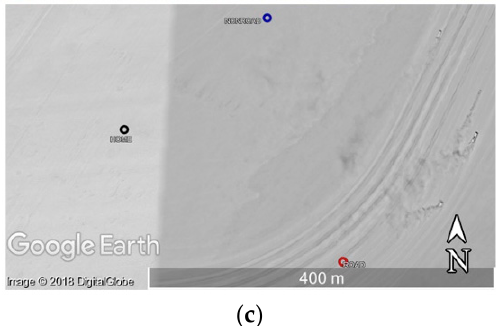
Figure 9. Field site locations: ( a ) Overview of Black Rock Desert (BRD) located north of Reno. ( b ) Zoomed-in Google Earth image over the BRD showing proximity to annual Burning Man Festival (the half circle). ( c ) Zoomed in Google Earth image over the location where measurements were made. The blue circle (most north) represents “non-road” (40.749586, − 119.261153), the red circle (most south) represents “road” (40.748192, − 119.258969) and the black circle in the middle represents the location of the UAS pilot (40.748345, 119.263186).